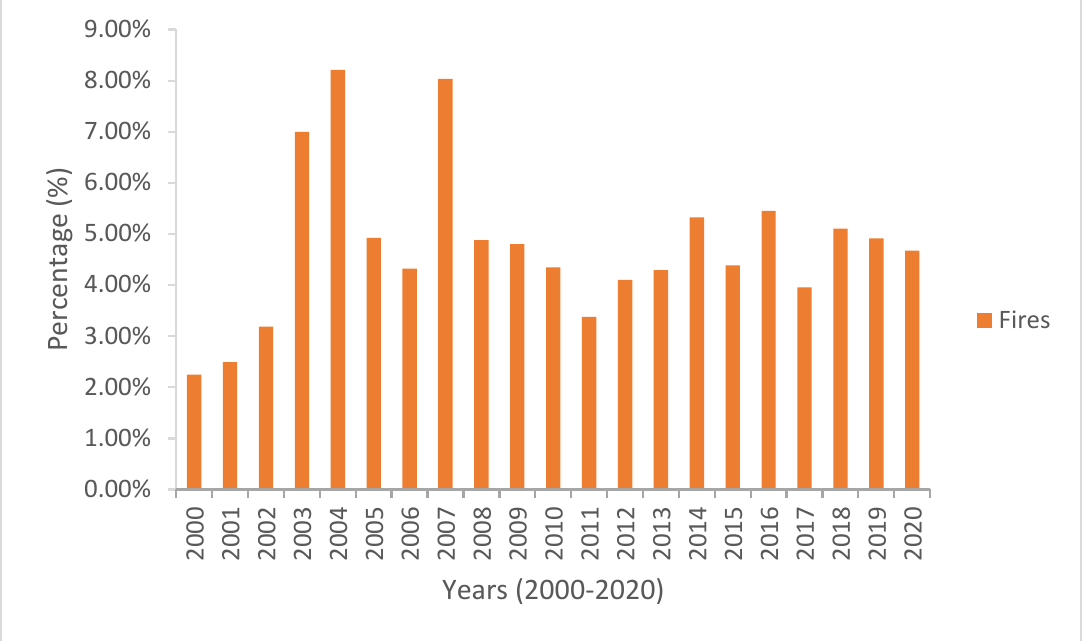
Figure 2. Annual distribution of fires (%) in Colombia from 2000 to 2022. The highest peak can be observed in 2004, followed by 2003 and 2007, respectively.